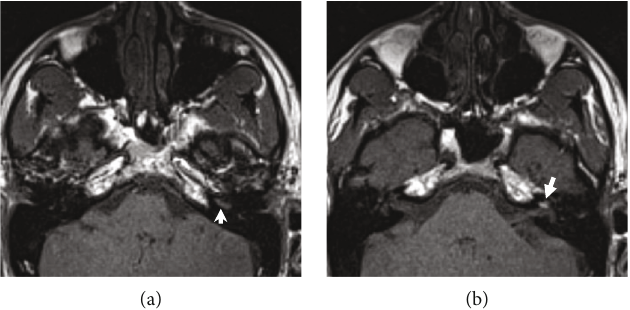
Figure 1: Magnetic resonance imaging of the temporal bone: axial T1-weighted slice before gadolinium injection showing hyperintensity of cochlear basal (a) and second turns (b) of the left ear with a normal signal in the right ear.